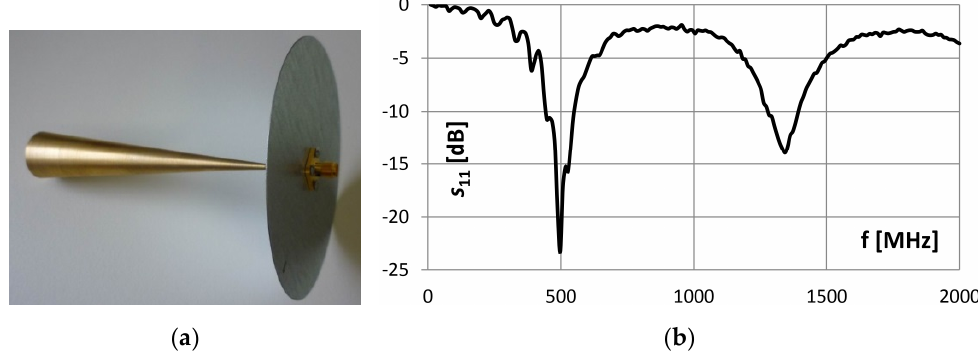
Figure 4. The monopole conical antenna for detecting PD radiated EM impulses ( a ), arm length 155 mm, end diameter of the arm 30 mm; reflection coefficient s 11 of the monopole ( b ).